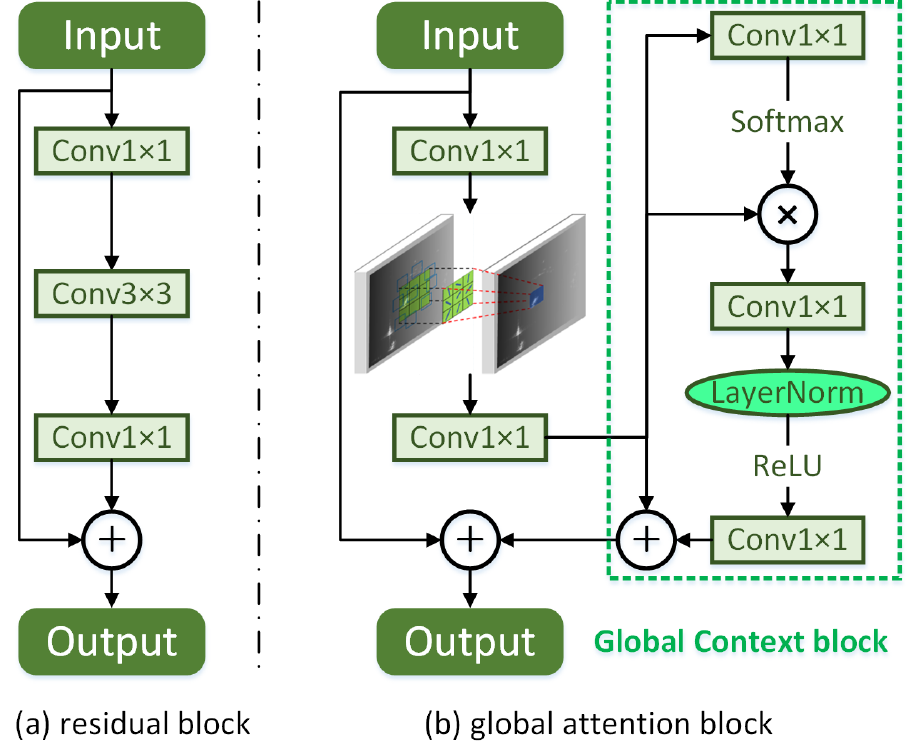
Figure 2. The basic module unit in the traditional residual network and the residual structure with the introduction of the global attention